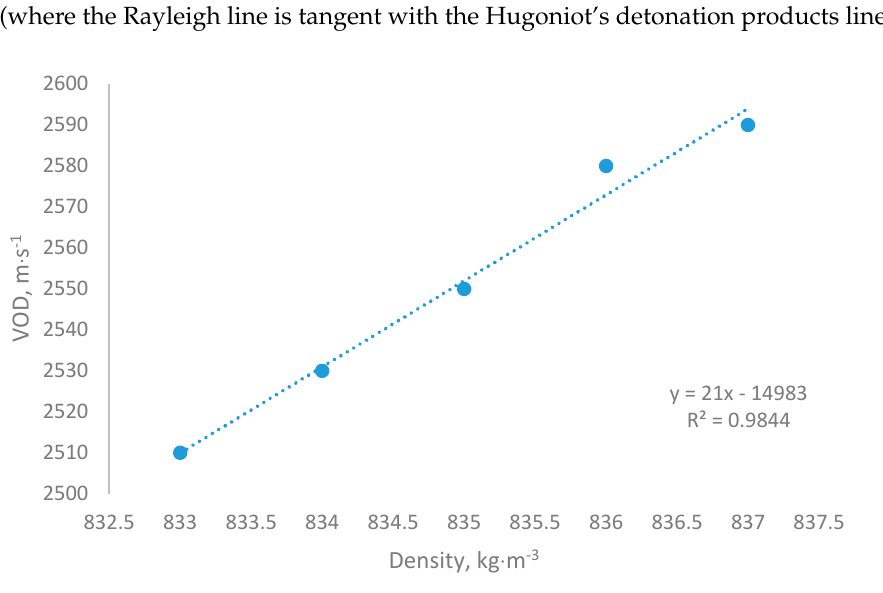
Figure 4. Relation between ANFO’s VOD and density.